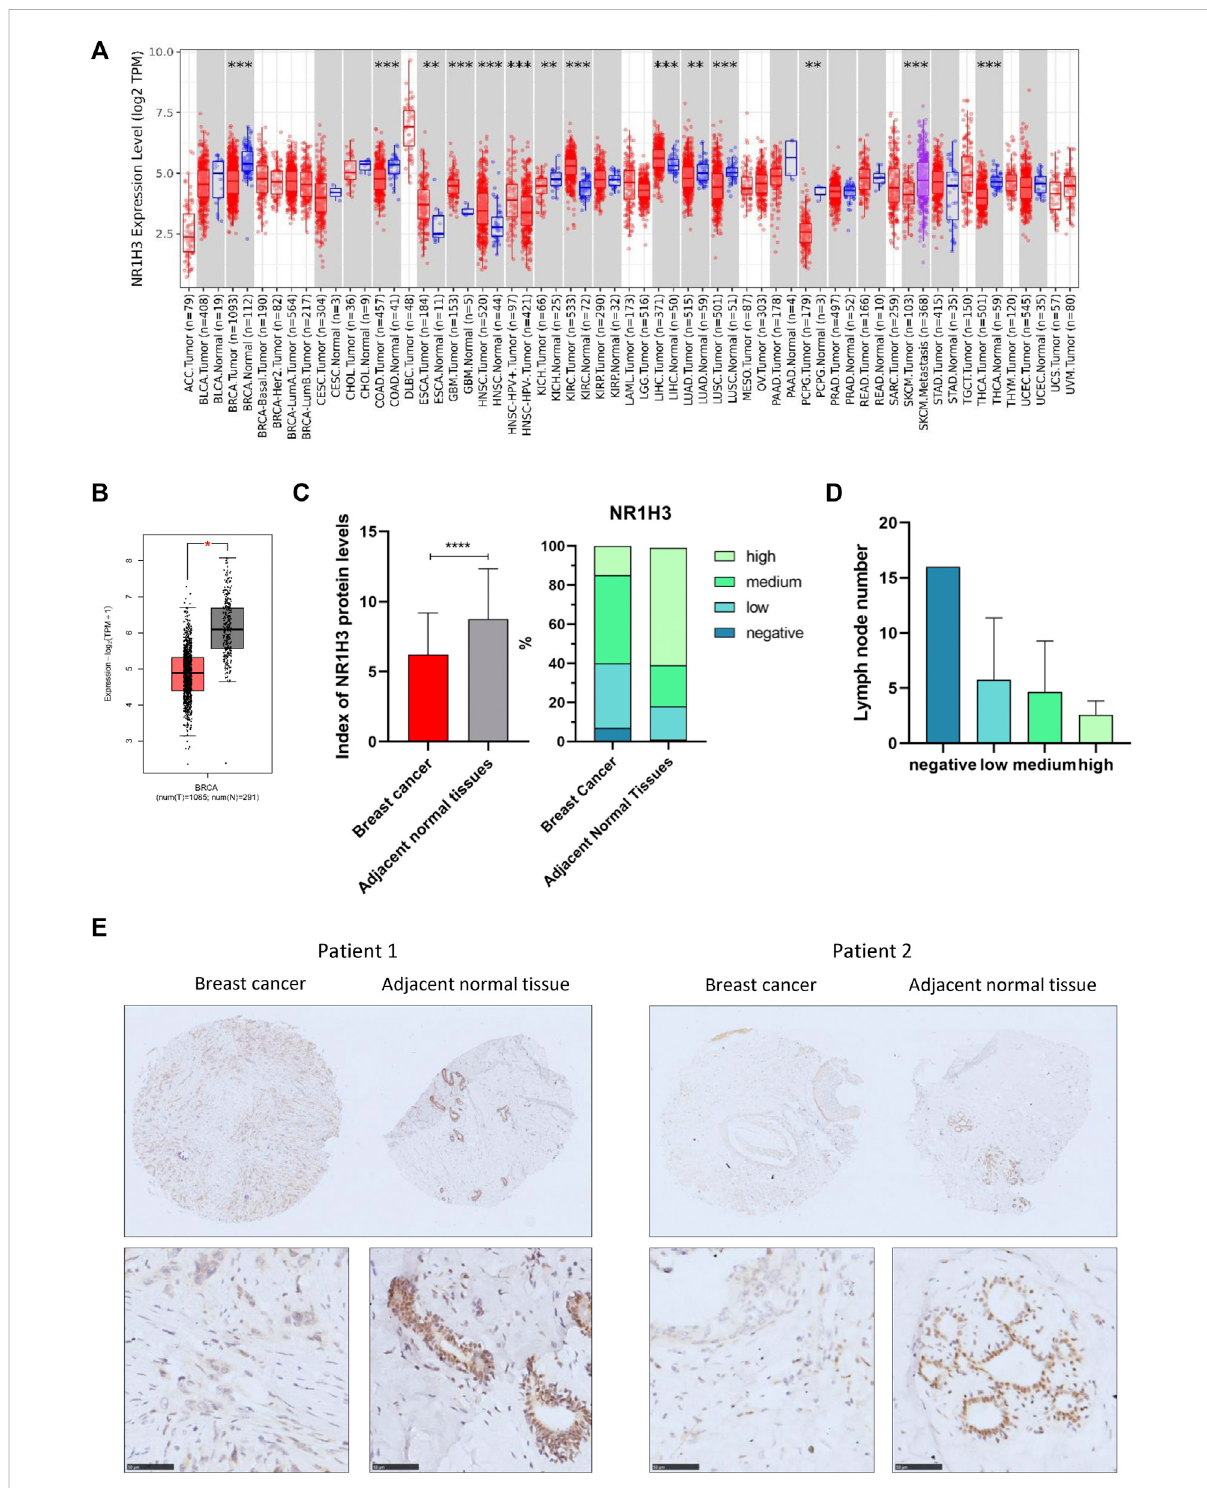
FIGURE 1 NR1H3 expression in different types of human cancers. (A) High or low expression of NR1H3 in different human cancer tissues compared with normal tissues from the TCGA database in TIMER2. (B) The level of NR1H3 expression in BRCA using GEPIA2 database. (C) Index of NR1H3 protein expression and IHC score groups distribution in breast cancer and adjacent normal tissues. p < 0.0001 (D) The number of lymph node metastasis in differentNR1H3proteinexpressiongroupsinbreastcancer. (E) ImmunohistochemistryanalysisofNR1H3proteininbreastcancerandadjacent normal tissues. Scalebar =50 μ m.BRCA, breastinvasive carcinoma; IHC,immunohistochemical.* p < 0.05, ** p < 0.01,*** p < 0.001, **** p <